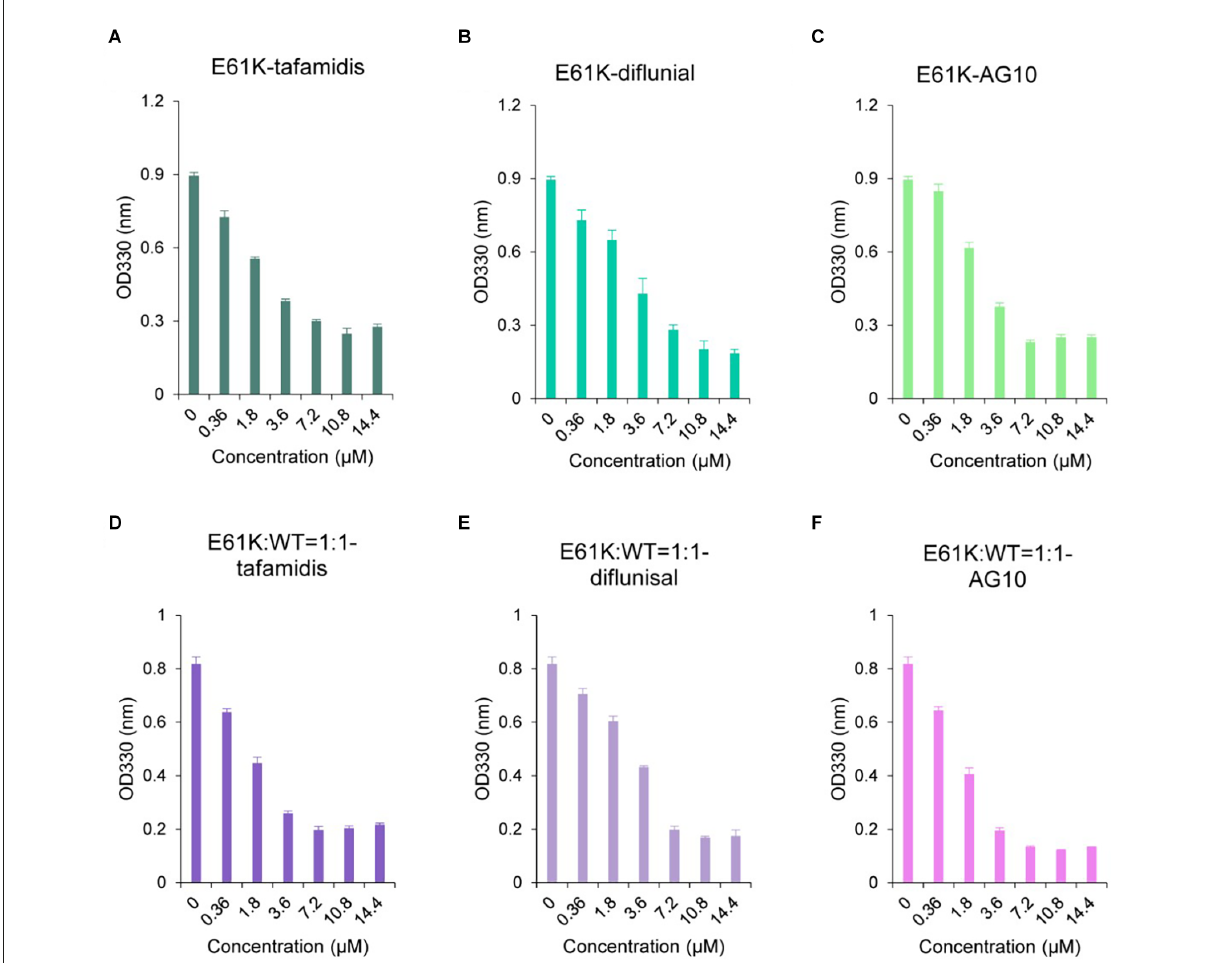
FIGURE4 Comparison of the inhibitory effect of small molecule stabilizers on fiber formation of pure E61K-TTR and E61K:WT-TTR heterozygous mixture. (A) Tafamidis with E61K-TTR. (B) Diflunisal with E61K-TTR. (C) AG10 with E61K-TTR. (D) Tafamidis with E61K:WT-TTR was measured after mixing E61K-TTR and WT-TTR in equal amounts at 4 ◦ C for 48 h. (E) Diflunisal with E61K:WT-TTR. (F) AG10 with E61K:WT-TTR.TTR concentration was 3.6 µ M. Fibril formation was induced by incubating the TTR protein-small molecule complexes in acidic buffer (NaOAc 200 mM, KCl 100 mM, acidified by AcOH to pH = 4.4) at 37 ◦ C for 72 h. The amount of TTR fibrils was determined by measuring the turbidity at 330 nm. Heterozygous E61K:WT-TTR exhibited similarly poor responses towards small molecule stabilizers compared to its pure E61K-TTR